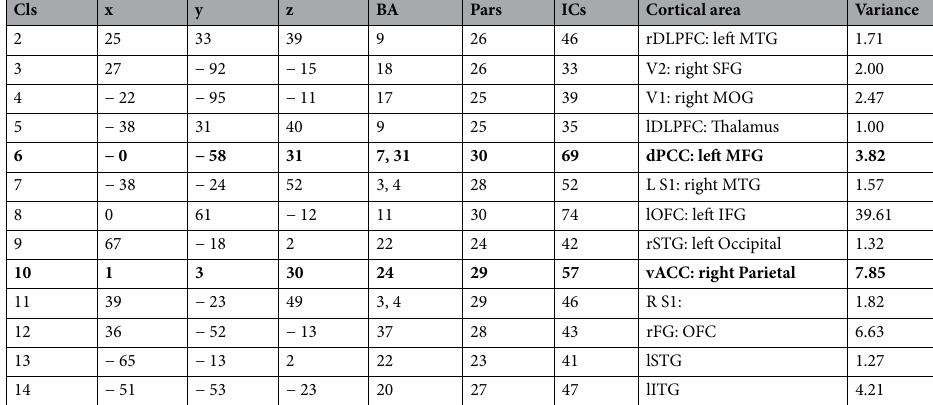
Table 1. MNI coordinates of the averaged dipole location for all clusters. Cluster number 1, the parent cluster, was excluded. The bold rows correspond to the clusters selected for future analyses. The Brodmann Area (BA) was detected using the Talairach coordinates, which were converted from the MNI coordinates. Cls cluster, Pars number of participants, ICs number of independent components included in the cluster, Variance the variance across EEG waveforms of all ICs involved in the cluster, MTG Middle Temporal Gyrus, SFG Superior Frontal Gyrus, MOG Middle Occipital Gyrus, MFG Middle Frontal Gyrus, MTG Middle Temporal Gyrus, IFG Inferior Frontal Gyrus, OFC Orbitofrontal cortex, SOM Somatosensory Area, STG Superior Temporal Gyrus.